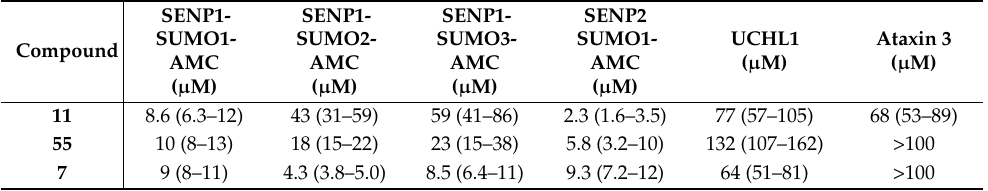
Table 4. IC 50 values of 11 (ZHAWOC8697), 55 and published compound 7 [21]; n = 2.